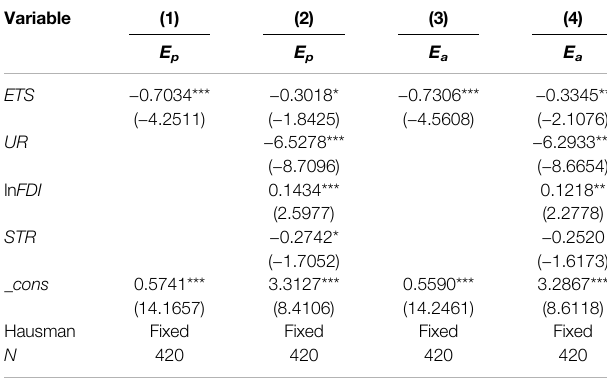
TABLE 2 | Regression results for the carbon trading policy on two carbon emission decoupling indicators. Variable